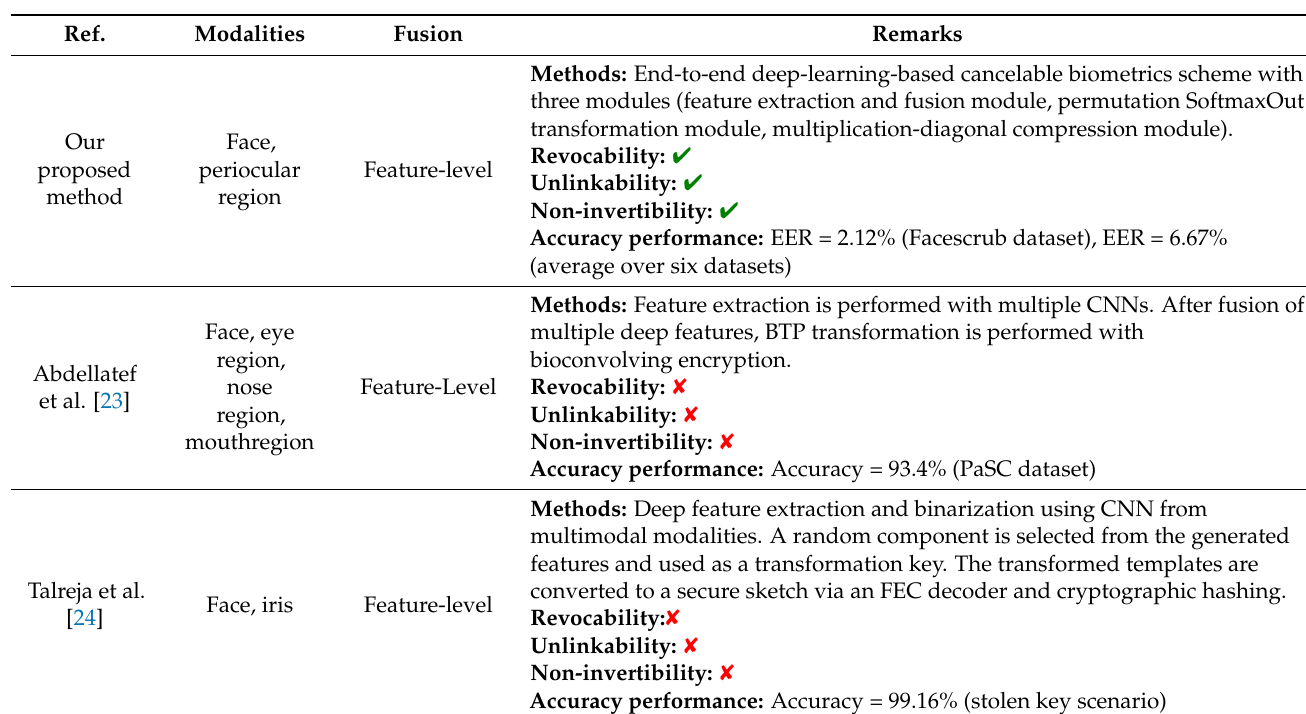
Table 7. Summary of works related to cancelable multimodal biometric